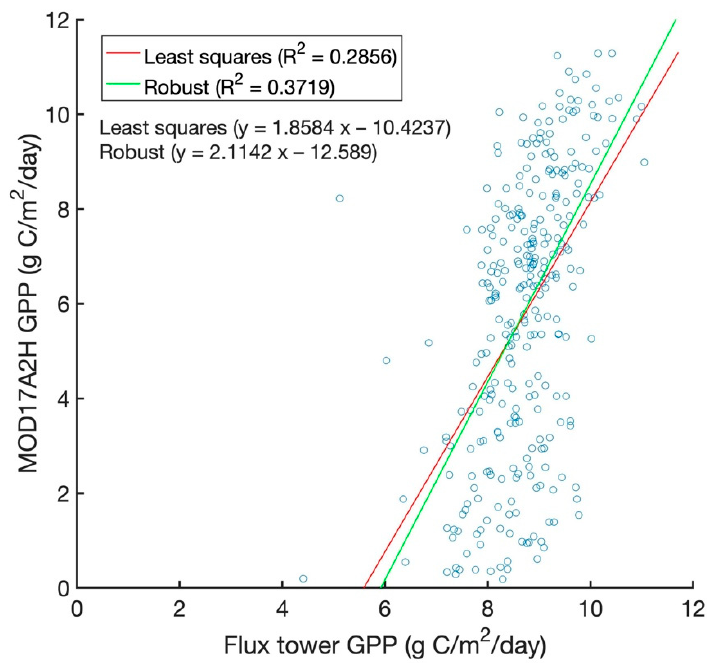
Figure 4. Scatter plots of the daily gross primary production (GPP) data (g C / m 2 / day) derived from the drained forest ( DF ) tower ( x -axis) and MODIS ( y -axis). Linear fitting equations were obtained from the results of least squares method (red line) and robust regression method (green line).